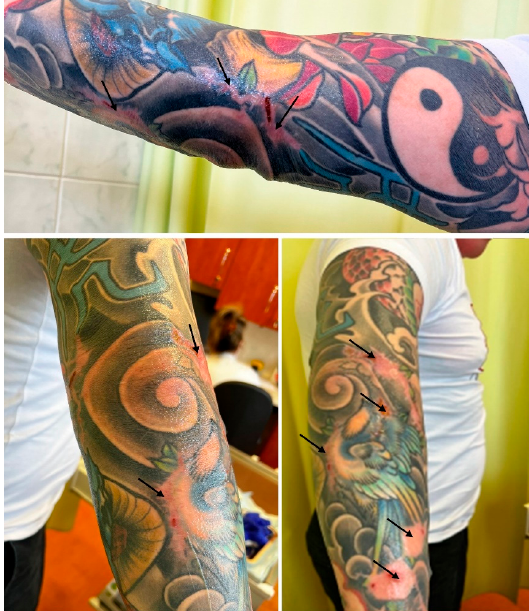
Figure 4. Patient’s forearm after staged excision of the red-pigmented parts of the tattoo (arrows— skin grafts and scars), remission of skin erythroderma and skin changes (3 months after completion of treatment).